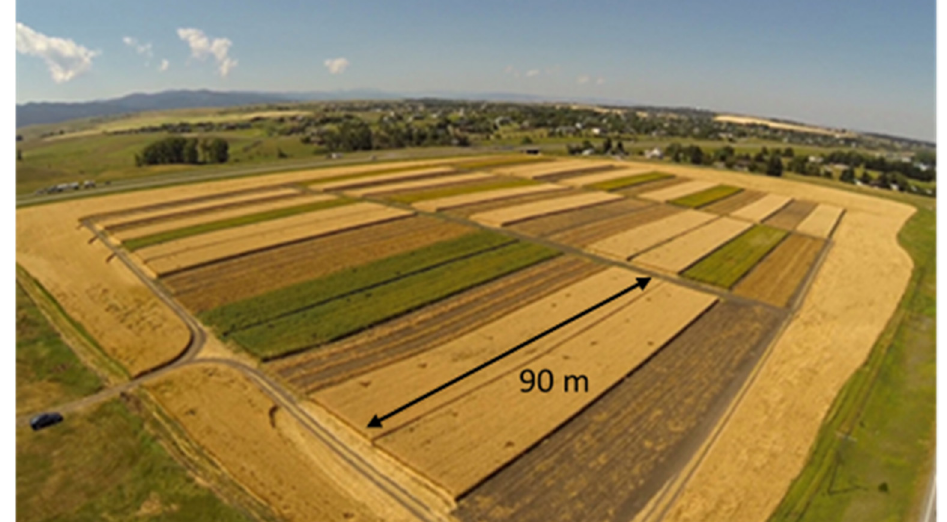
Figure 1. Fort Ellis study site located near Bozeman, MT, USA. The front row plots from left to right are organic-grazed minimum till, chemical no-till, and organic-till, respectively. The five subplots within plots are assigned to a five-year cropping sequence of safflower undersown with sweet clover (Year 1), sweet clover green manure (Year 2), winter wheat (Year 3), lentil (Year 4), and winter wheat (Year 5).